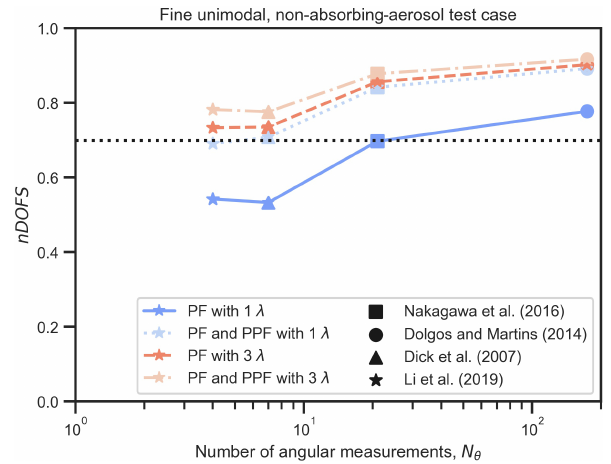
Figure 3. Variation in nDOFS for spectral polar, polarimetric, and angular configurations. The angular configurations are based on in- struments available in the literature. The dotted line corresponds to nDOFS equalling 0.7 and is included for